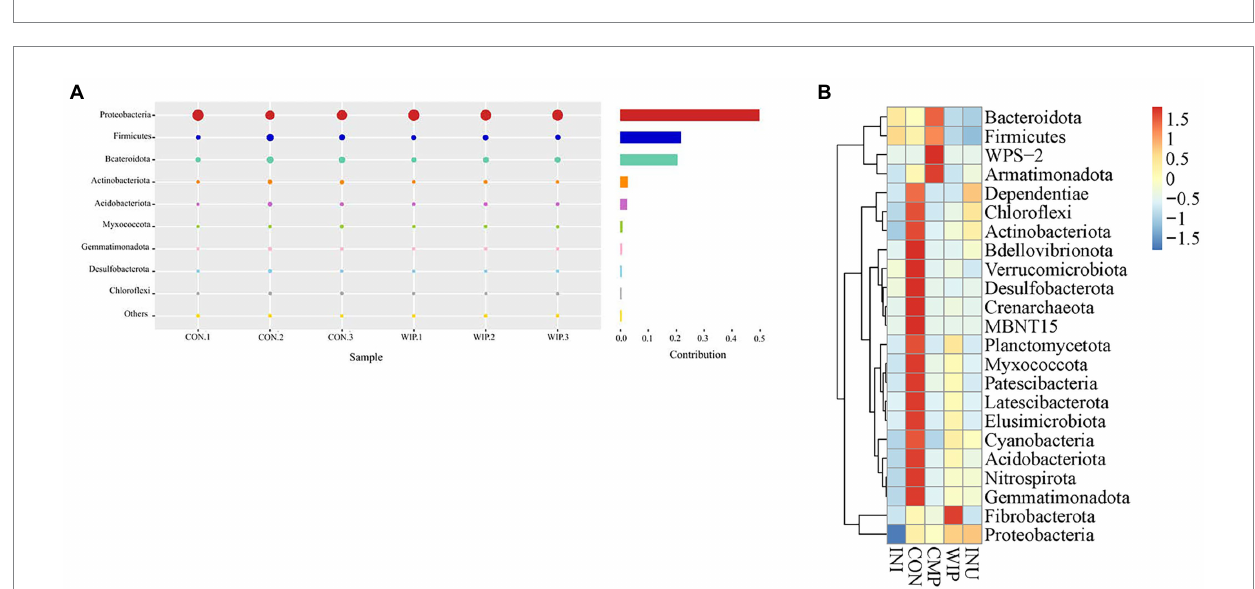
β -diversity analysis of gut microbial communities. (A) PCoA, (B) NMDS of WIP, CMP, and